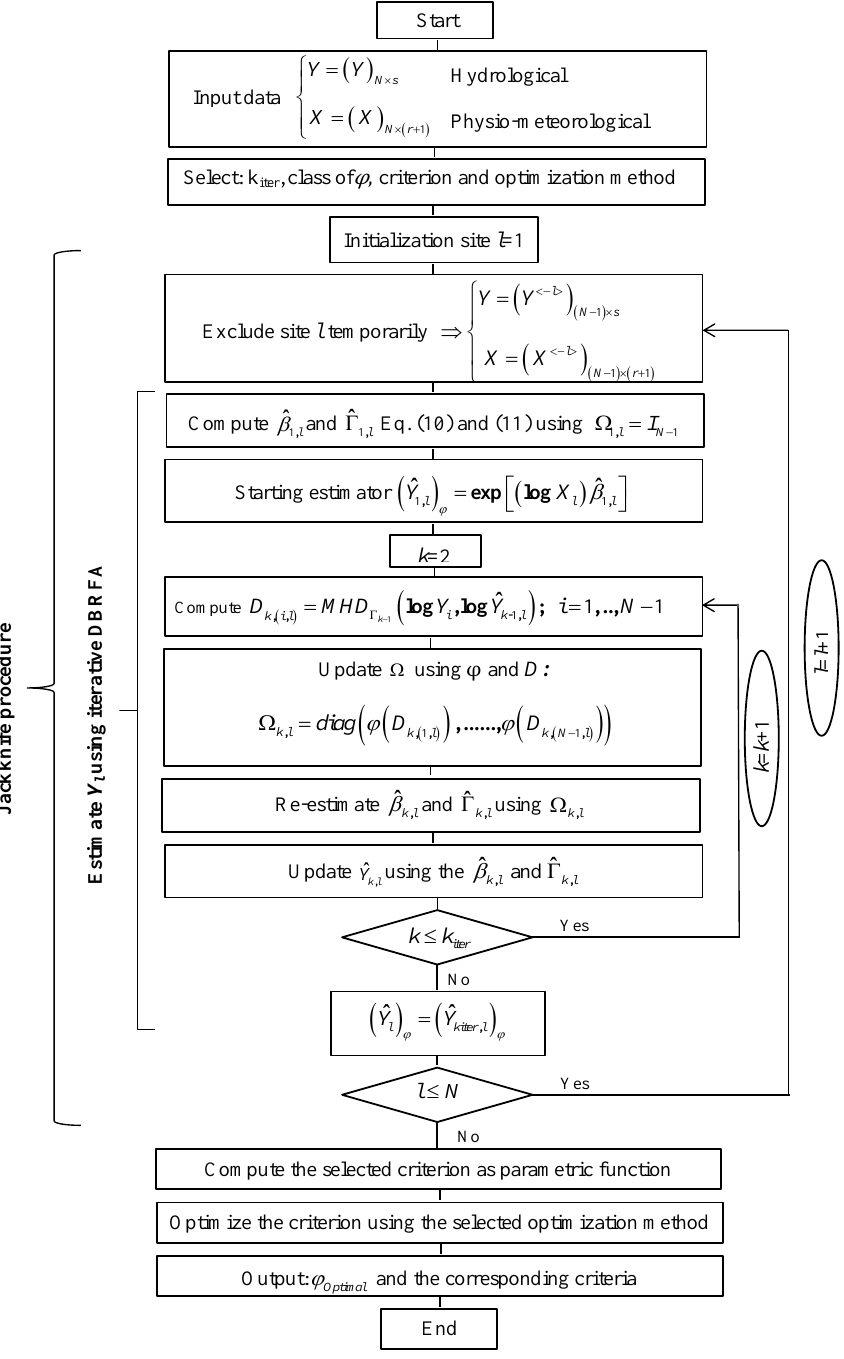
Fig. 2. An overview diagram summarizing the optimization procedure of the DBRFA approach.